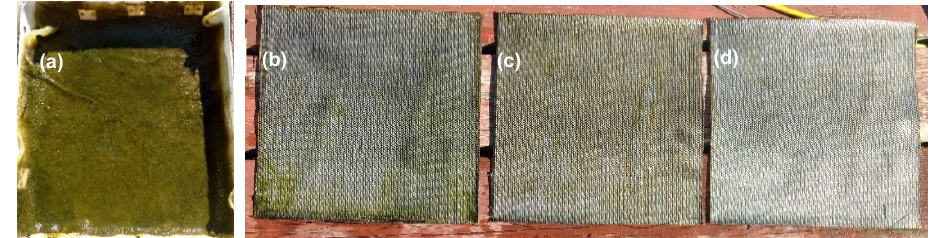
Figure 7. Woven geotextiles after one week of the filtration process for AOS order: ( a ) CM layer ( b ) TE-GMW35 first layer ( c ) TE-GMW35 s layer ( d ) TE-GMW35 third layer.